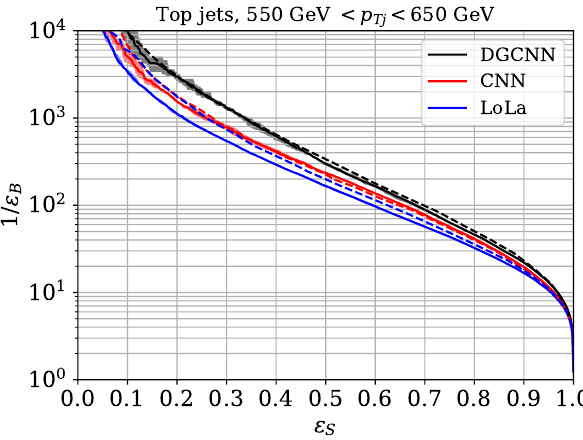
Figure 10: ROC curves for top tagging with the different neural networks architec- tures described in this appendix. The dashed lines denote the ROC curves of the corresponding architectures as presented in ref. [ 35 ]